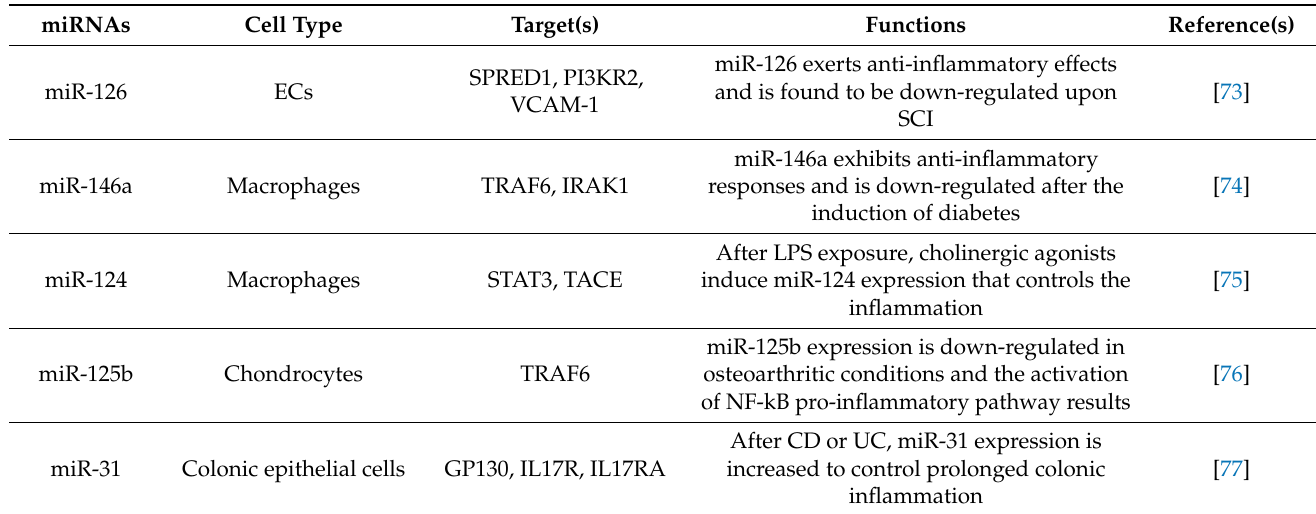
Table 2. Anti-inflammatory miRNAs, their targets, and